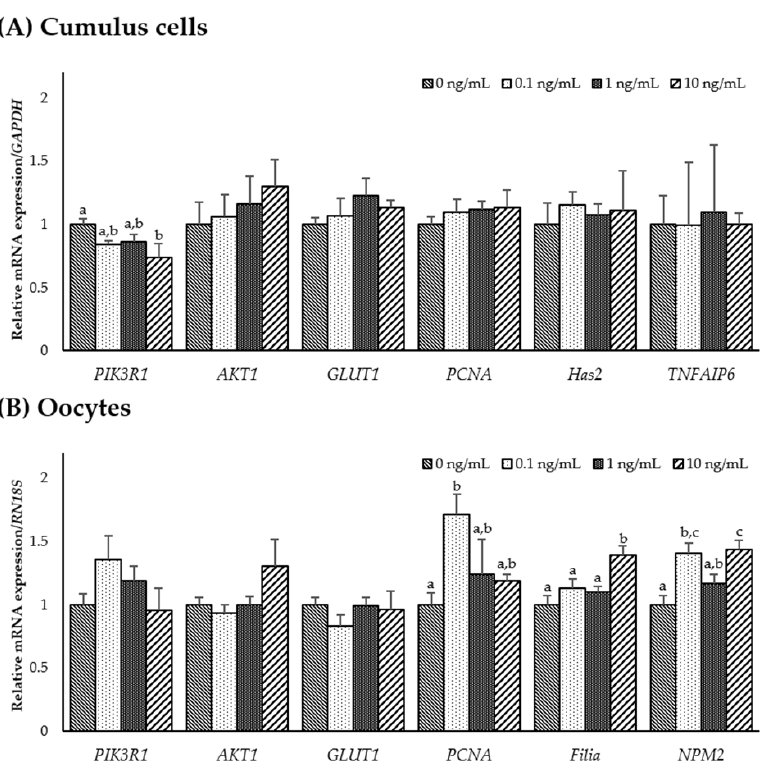
Figure 3. The mRNA expression levels (mean ± SEM) of interleukin-7 (IL-7)-associated and devel- opmental competence-related genes. Levels of PIK3R1 , AKT1 , GLUT1 , PCNA , Has2 , and TNFAIP6 assessed in groups of cumulus cells ( A ) and levels of PIK3R1 , AKT1 , GLUT1 , PCNA , Filia , and NPM2 assessed in groups of oocytes ( B ) supplemented with various concentrations of IL-7 after in vitro maturation. The experiment was replicated three times. The bars with different letters (a–c) are significantly different ( p < 0.05).